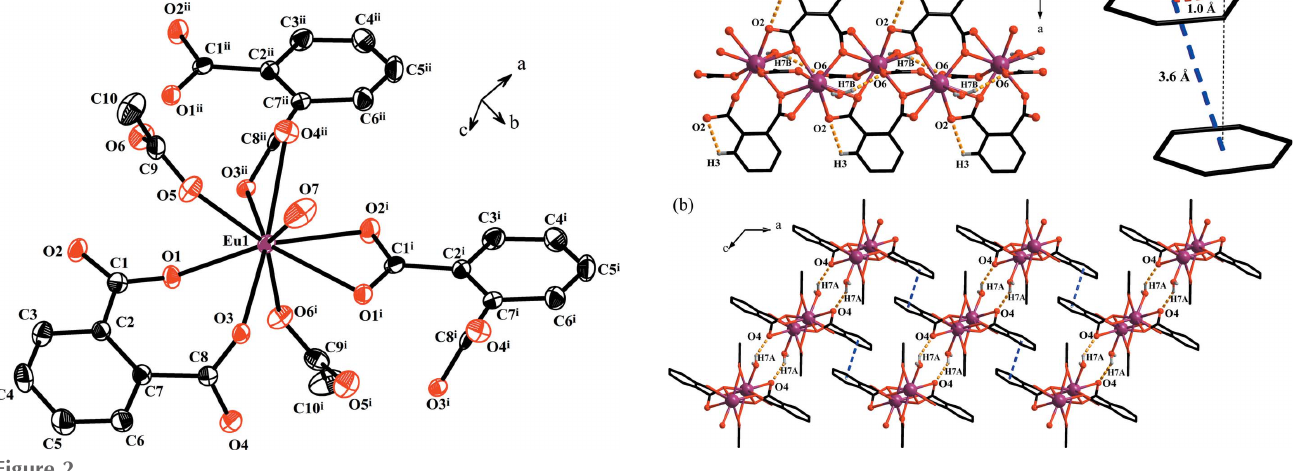
Figure 3 Depiction of ( a ) intrachain and ( b ) interchain hydrogen-bonding interactions, and ( c ) (cid:3) – (cid:3) interactions.